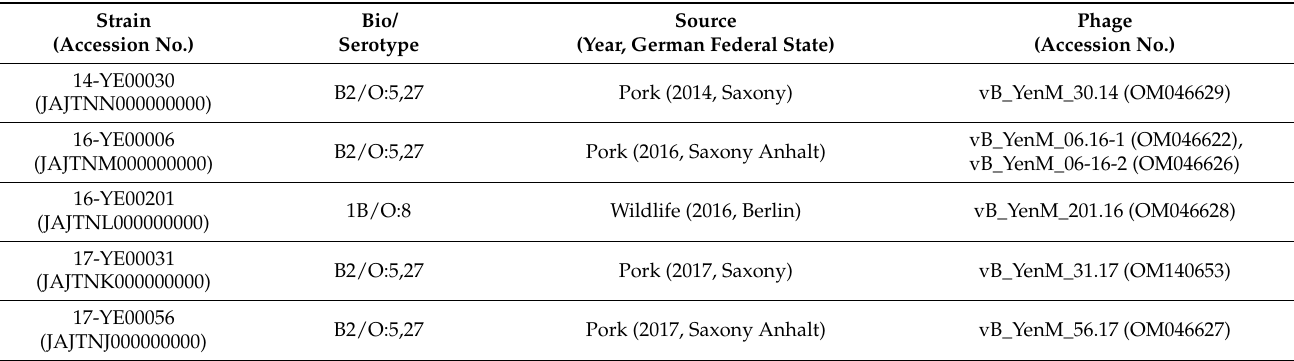
Table 1. Lysogenic Y. enterocolitica strains and released